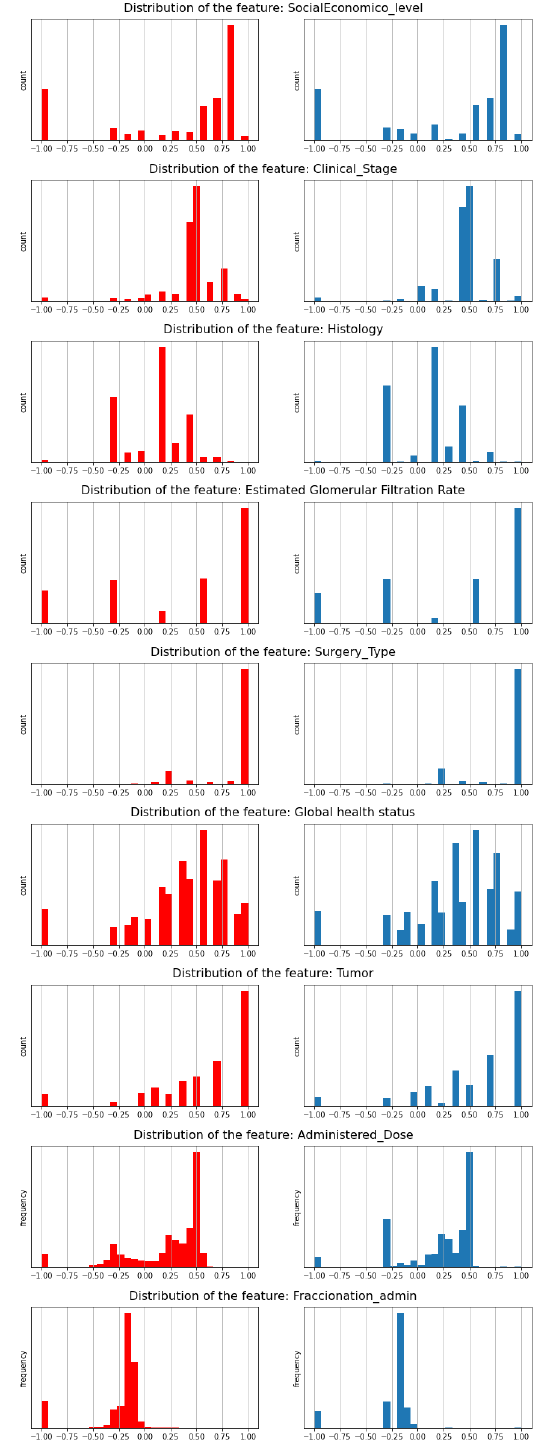
Figure 5. Distribution of the features with p -values greater than level of significance at 0.01 for synthetic and real